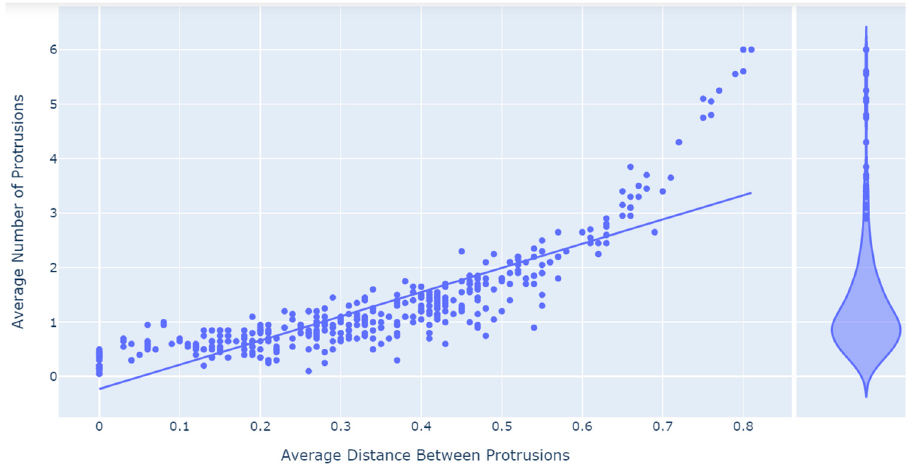
Figure 13. Scatter plot for average distance between protrusions and average number of protrusions.